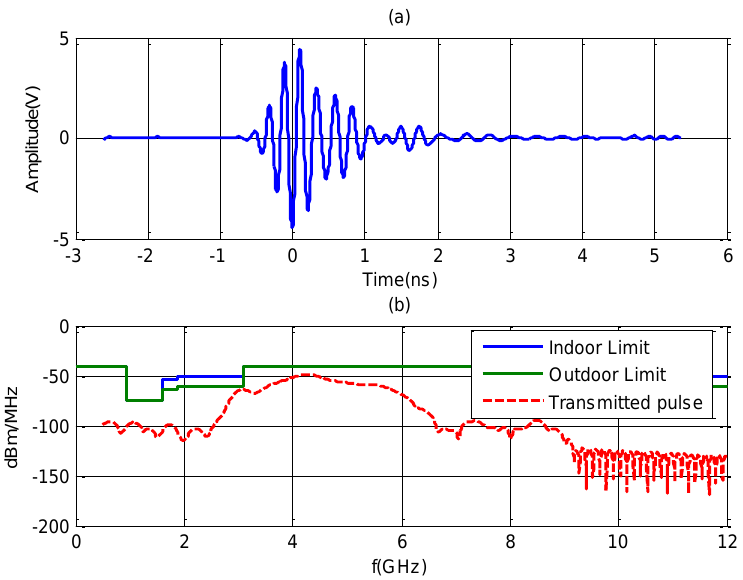
Figure 2. ( a ) Measured transmitted pulse in time-domain; and ( b ) the power spectrum density (PSD) of UWB transmitted pulse and FCC indoor and outdoor